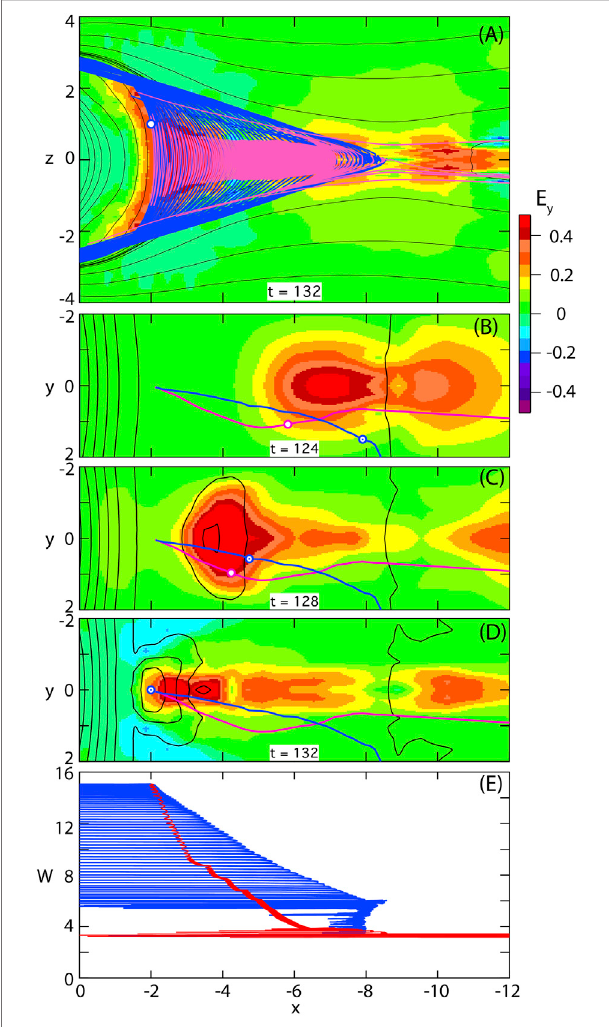
FIGURE 7 | Electron orbits contributing to the enhanced CPS fl uxes at ( − 2, 0, 1). Blue curves represent an electron contributing to the fi eld-aligned beam, red/pink curves correspond to a ~ 90 ° pitch angle orbit contributing to the enhanced perpendicular fl uxes; (A) projection of the orbits into the x , z plane, (B – D) equatorial crossing points of the orbits in the x , y plane, superposed on snapshots of the color-coded electric fi eld, with the particle locations at t = 124, 128, 132 shown as white dots; (E) particle energies as function of x